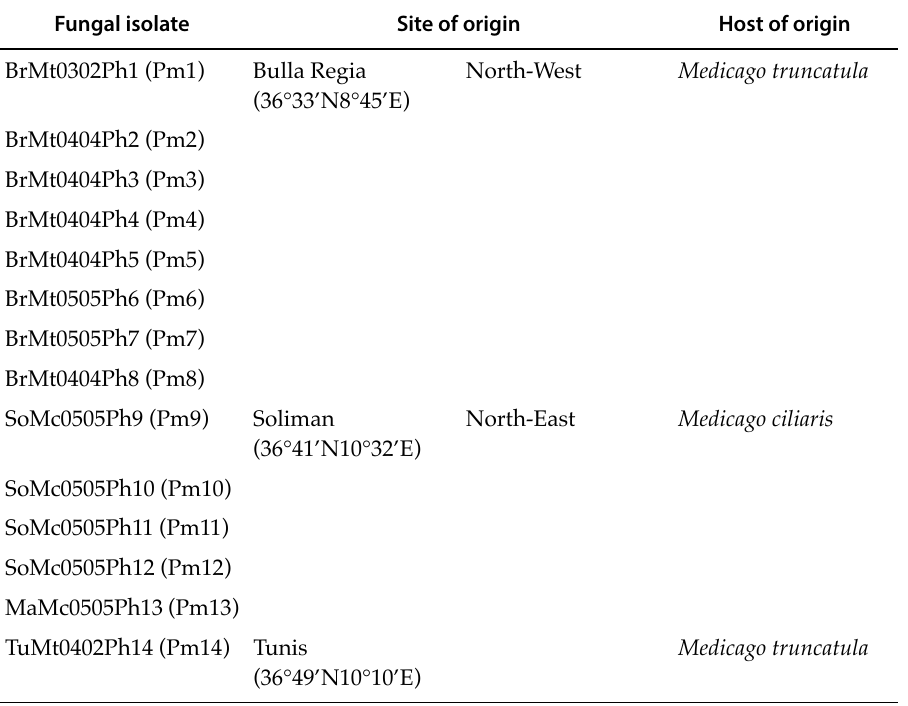
Table 1. List of the studied Phoma medicaginis isolates, and their sites (in Tunisia) and hosts of origin. Fungal